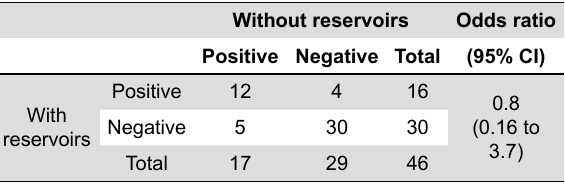
Table 3- Matched tabulation* of the absolute risk of gingival irritation for both groups along with the odds ratio and 95% confidence interval